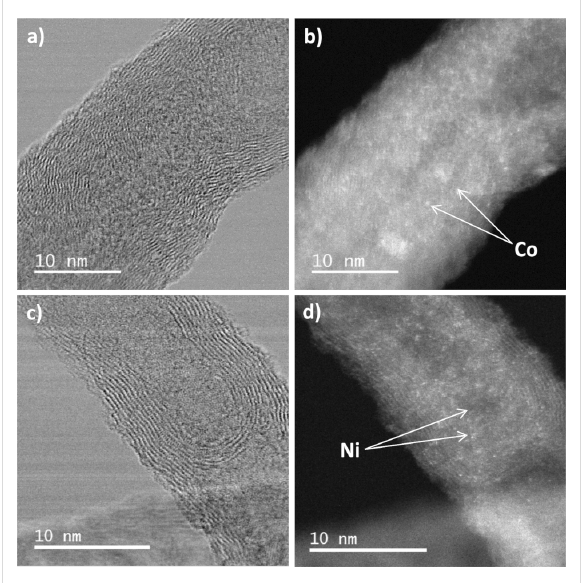
Figure 7: HRTEM images of a) Pt 3 Co/N-CNT and c) Pt 3 Ni/N-CNT HT , and STEM-HAADF images of b) Pt 3 Co/N-CNT and d) Pt 3 Ni/N-CNT HT .